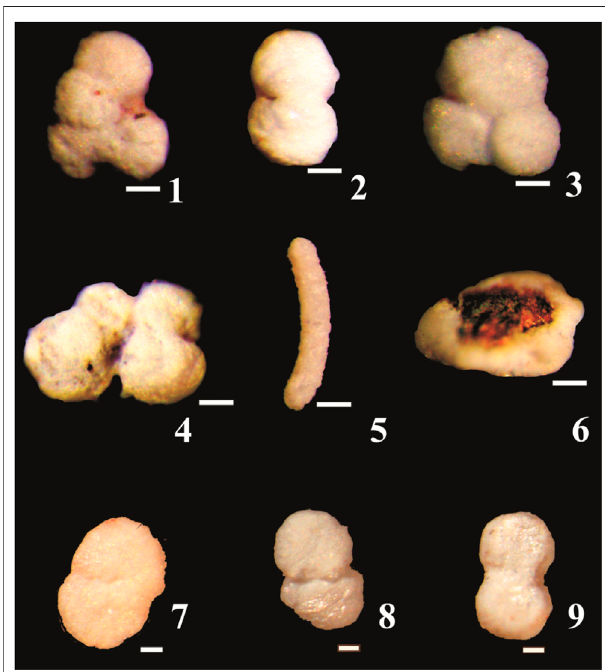
FIGURE 7 | Recovered specimens from the Proterozoic units of the São Francisco craton, São Domingos River section (samples from the Sete Lagoas, MP1221, and Serra de Santa Helena, MP1231, formations) and from São Domingos Hill section (sample from the Paranoá Group, MP1203), Municipality of Buritis, Minas Gerais State, Brazil. (1 – 5) Specimens from the Paranoá Group; (6) Specimens from the Sete Lagoas Formation, Bambuí Group; (7 – 9) Specimens from the Serra de Santa Helena, Bambuí Group. (1 – 4,7 – 9) Myxococcoides sp., respectively, CP965, CP966, CP967,